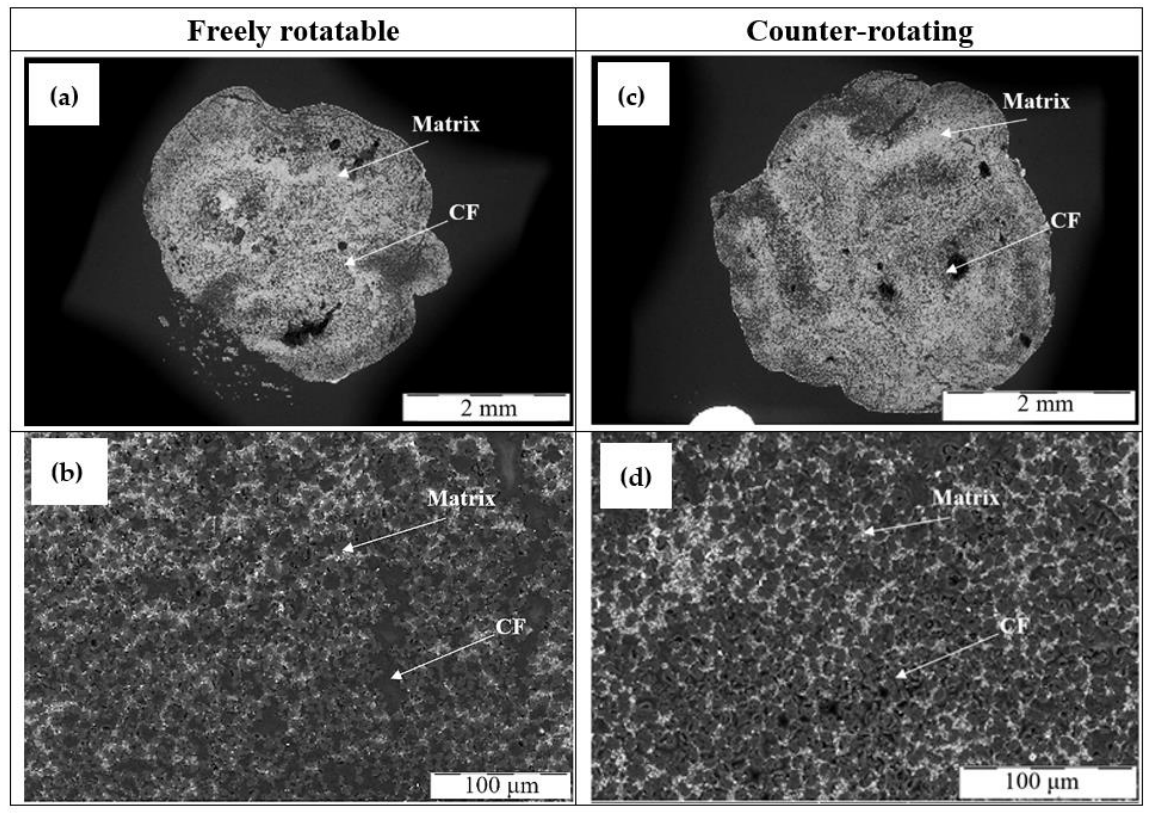
Figure 13. ESEM images showing cross-sections of MCFs ( a , b ) with freely rotating rollers and ( c , d ) the roller rotating in the counter direction.